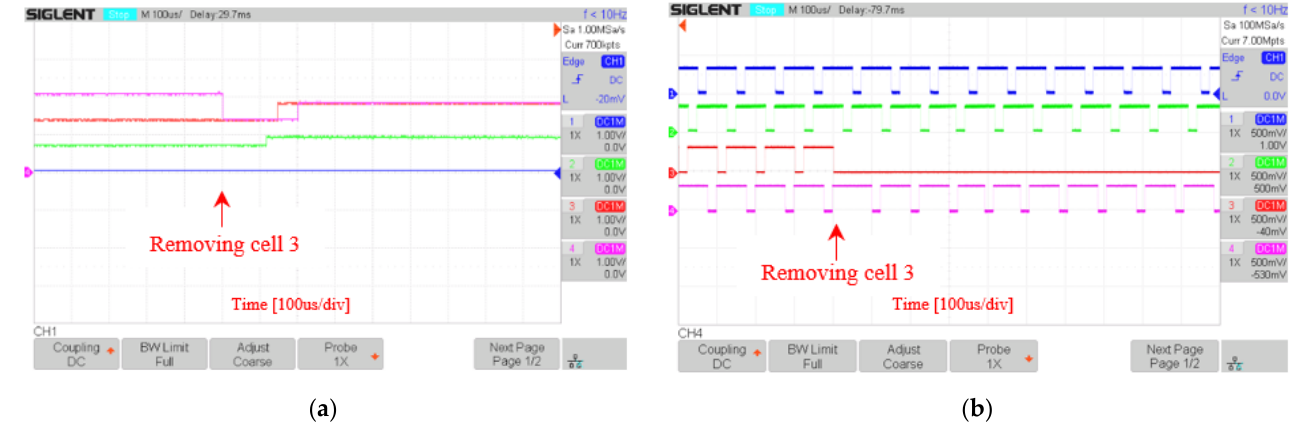
Figure 34. The system response when removing cell 3, ( a ) carrier phases; ( b ) PWM control signals.